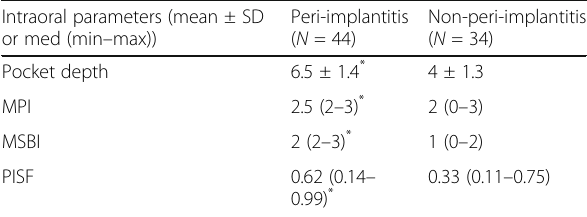
Table 1 Intraoral findings of sampling